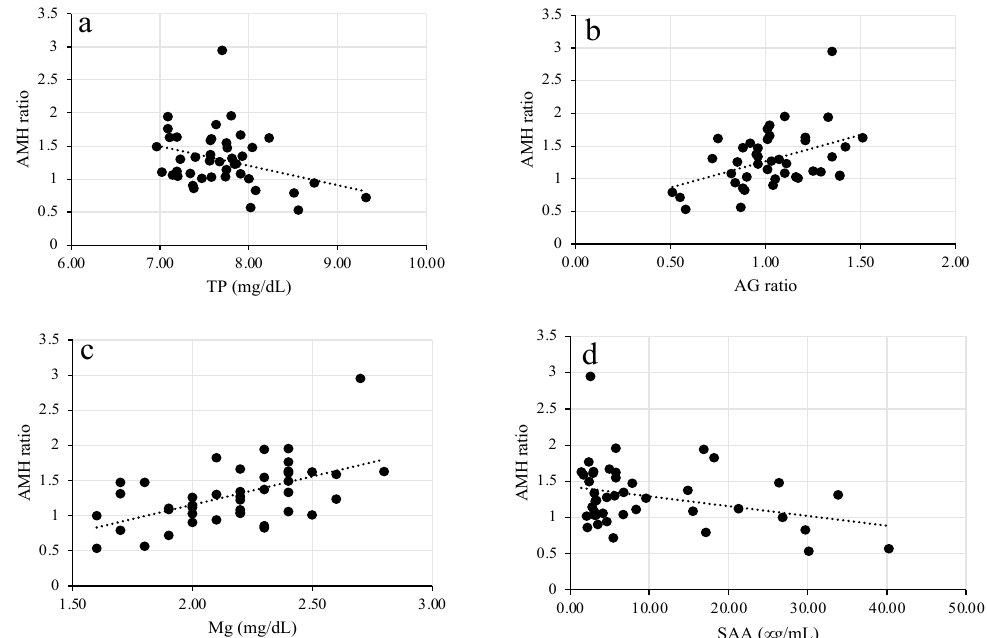
Figure 2. Representative significant correlation between the AMH ratio and ( a ) TP at D28, ( b ) A/G ratio at D28, ( c ) Mg at D10, and ( d ) SAA at D10.